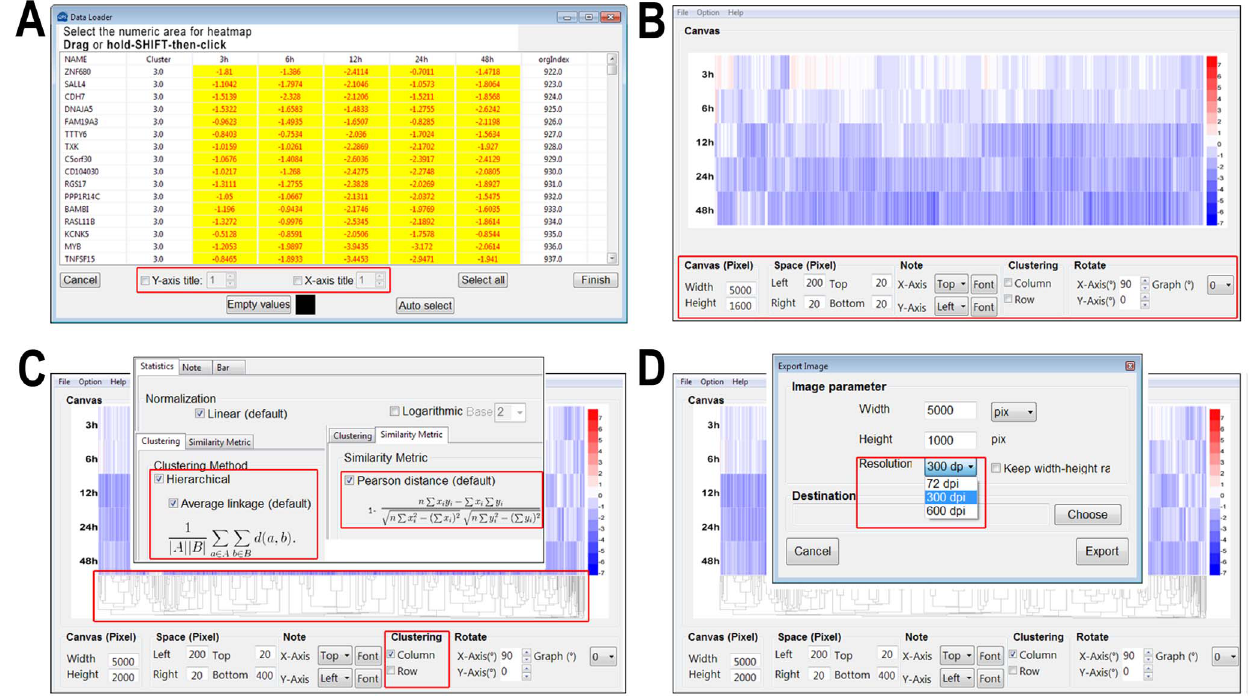
Figure 1. Usage of HemI 1.0. (A) The numerical data in one of three file formats can be directly loaded, whereas the data area can be selected by dragging or holding-SHIFT-then-click manipulations. Titles for X -axis or Y -axis can also be specified; (B) Multiple options for manipulating the heatmp; (C) The numeric data can be clustered for either or both of X -axis and Y -axis; (D) Publication-quality figures can be exported, and two figure formats were supported.